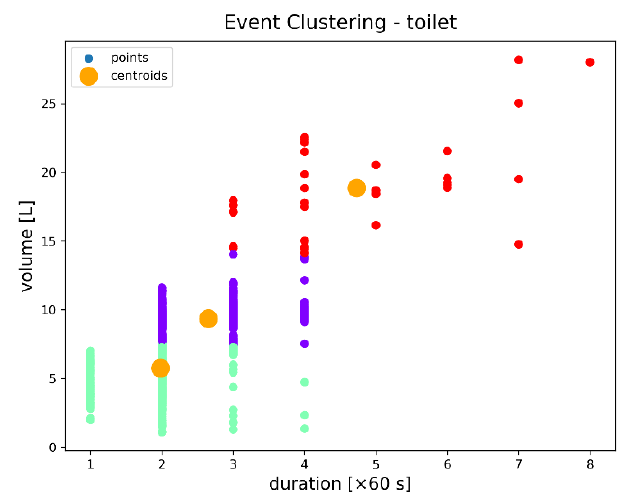
Figure 8. Consumption event clustering—toilet.